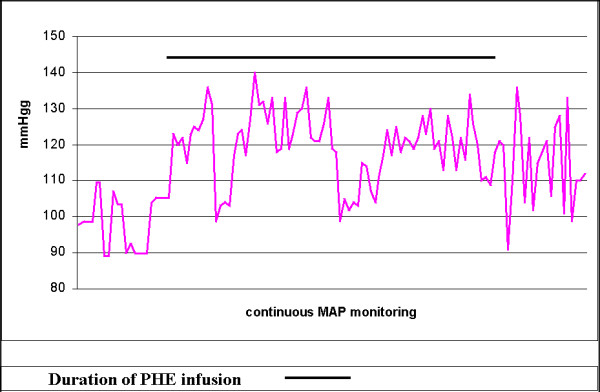
Mean MAP on admission, during induced hypertension (days 1–5) and tapering off (days 6–7).